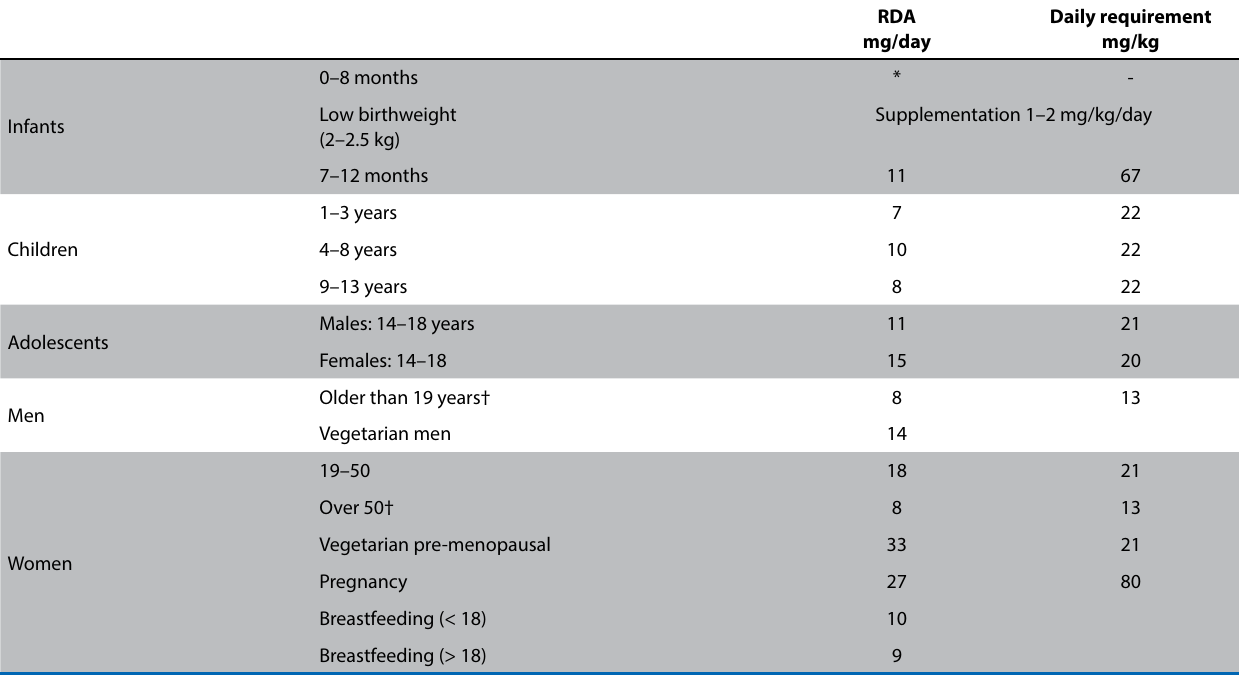
Table l: Recommended daily allowance (mg/day) and daily requirement (mg/kg/day) of elemental